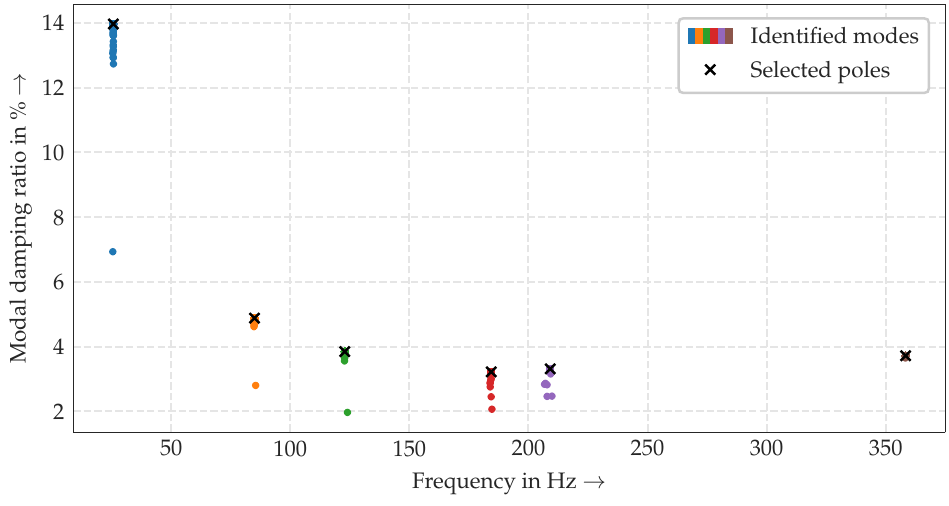
Figure 3. Identified modes by agglomerative clustering with a maximum frequency distance d max of poles within a cluster; different clusters, that is, distinct modes, are indicated by different colors. The finally selected poles are marked with a cross.